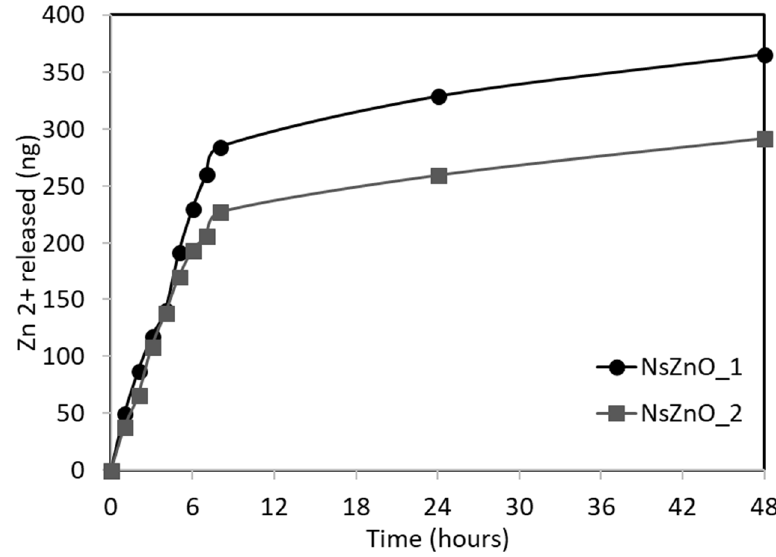
Figure 7. In vitro Zn 2+ release from NsZnO-1 and NsZnO-2.